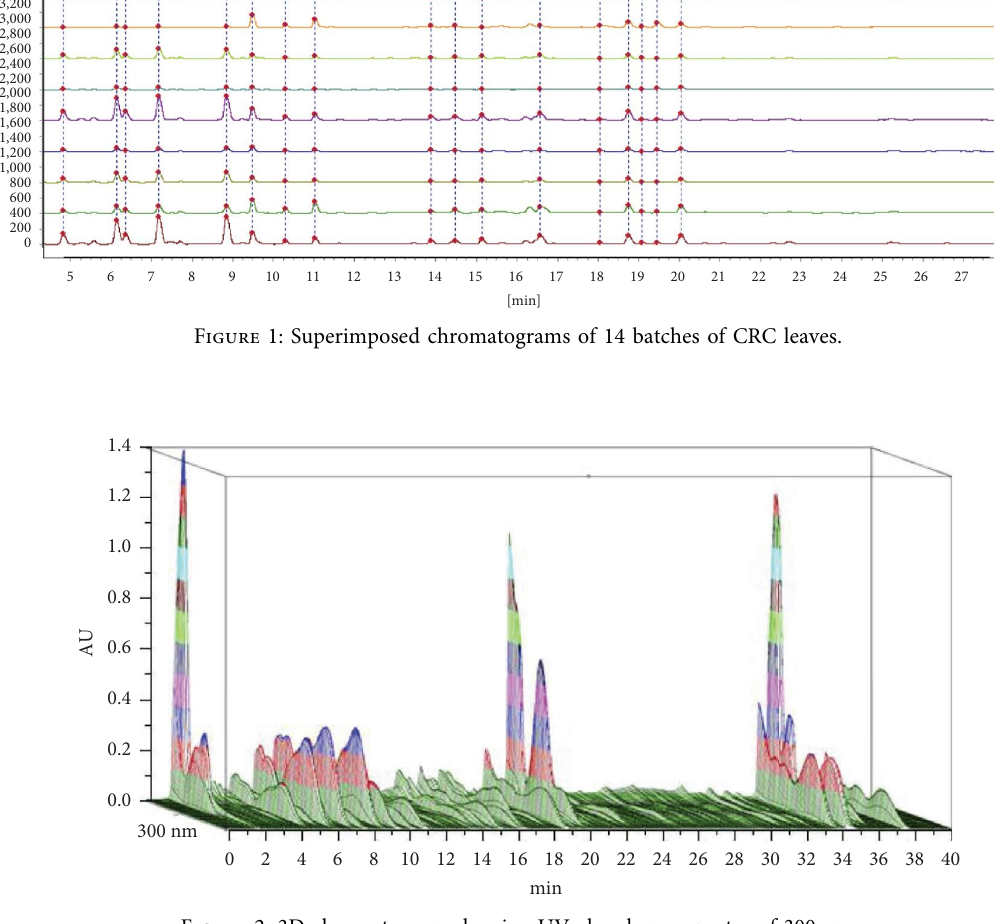
Figure 2: 3D chromatogram showing UV absorbance spectra of